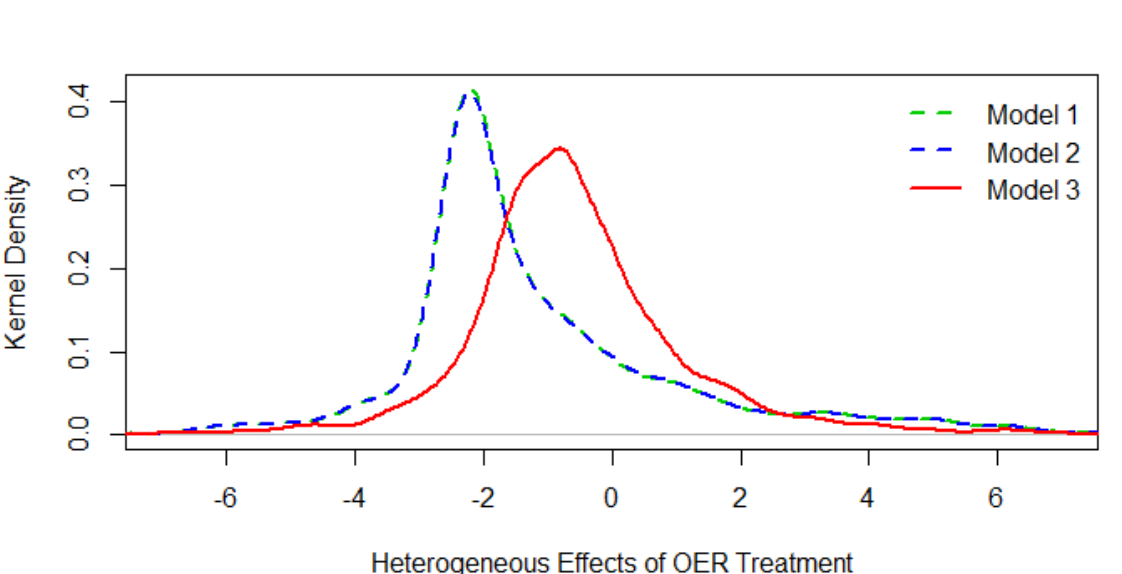
Figure 1. Kernel densities of the heterogeneous OER effects on student final exam scores from three nonparametric